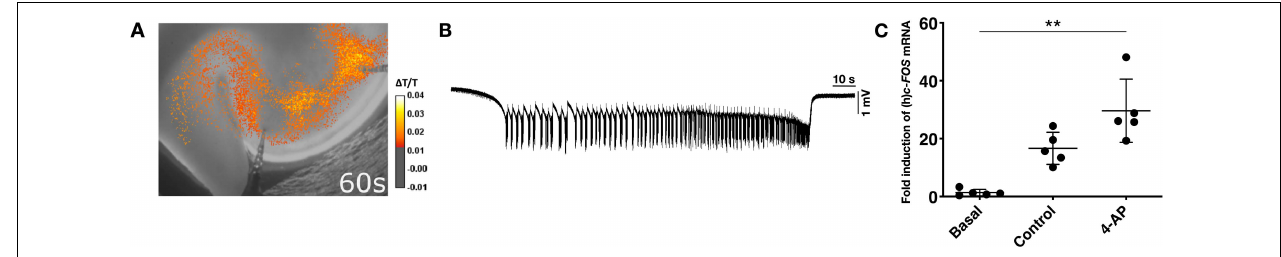
FIGURE 7 | Activity-dependent c-FOS expression in human slices. (A) Example of a typical IOS image of a SLE in a human cortex slice at 60 s after start. (B) Example of an electrophysiological trace showing a SLE recorded in human cortical layers II/III upon application of aCSF containing 8 mM potassium and 100 µ M 4-AP. (C) Scatter plots showing c-FOS expression fold changes relative to basal condition. All data are normalized to the reference gene RPL13A and expressed as median ± interquartile range. c-FOS expression in slices displaying SLE activity is higher when compared to basal condition (** p < 0.01, n =